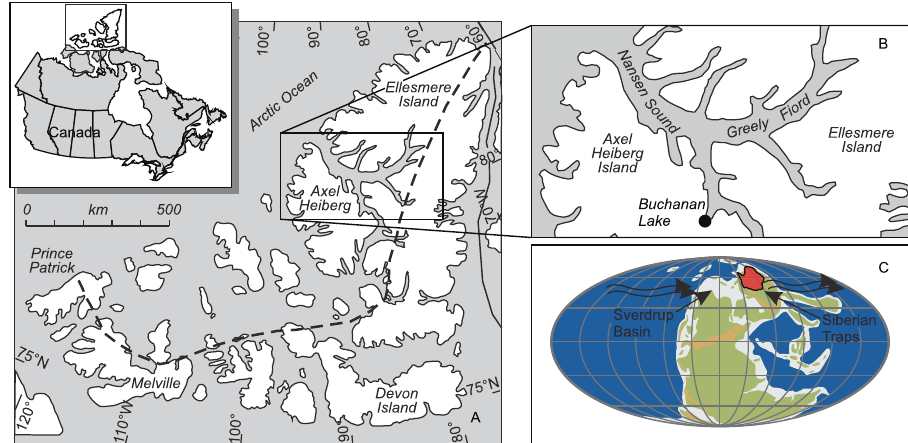
Fig. 1 Regional map showing the location of the study area in Arctic Canada (after ref. 22 ). A Regional map. B Detailed map showing the location of the Buchanan Lake section. C Permian palaeogeographic map showing the location of the Sverdrup Basin relative to the Siberian Traps volcanic rocks (base map after C.R. Scotese [http://www.scotese.com/]). Wavy arrows indicate predominant westerly wind